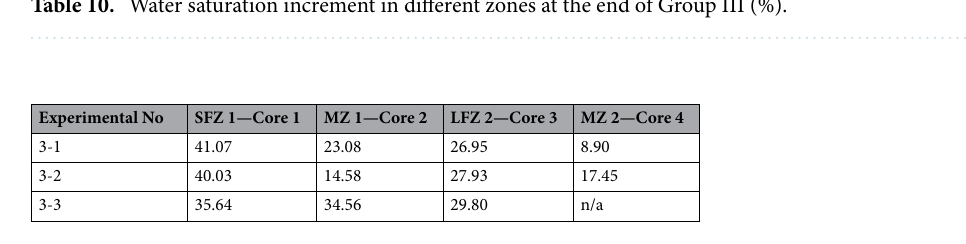
Table 11. Distribution of residual reserves in different zones at the end of Group III (%).